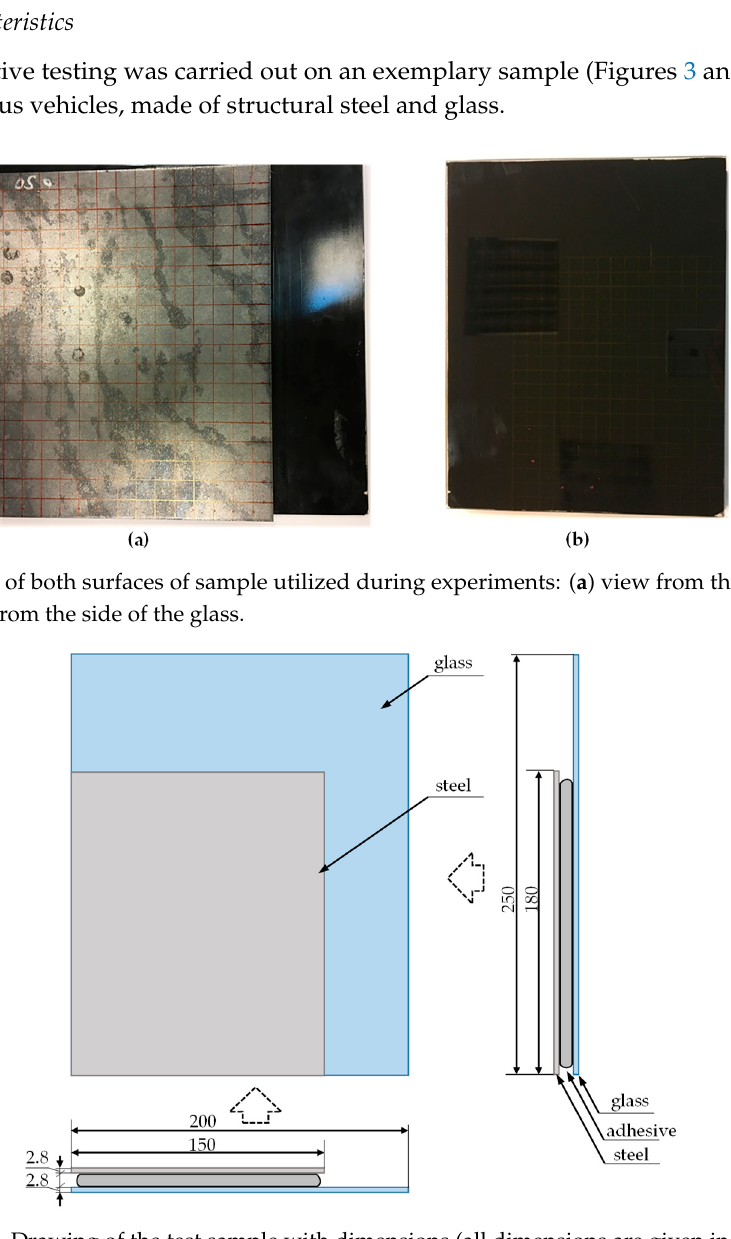
Figure 4. Drawing of the test sample with dimensions (all dimensions are given in mm).